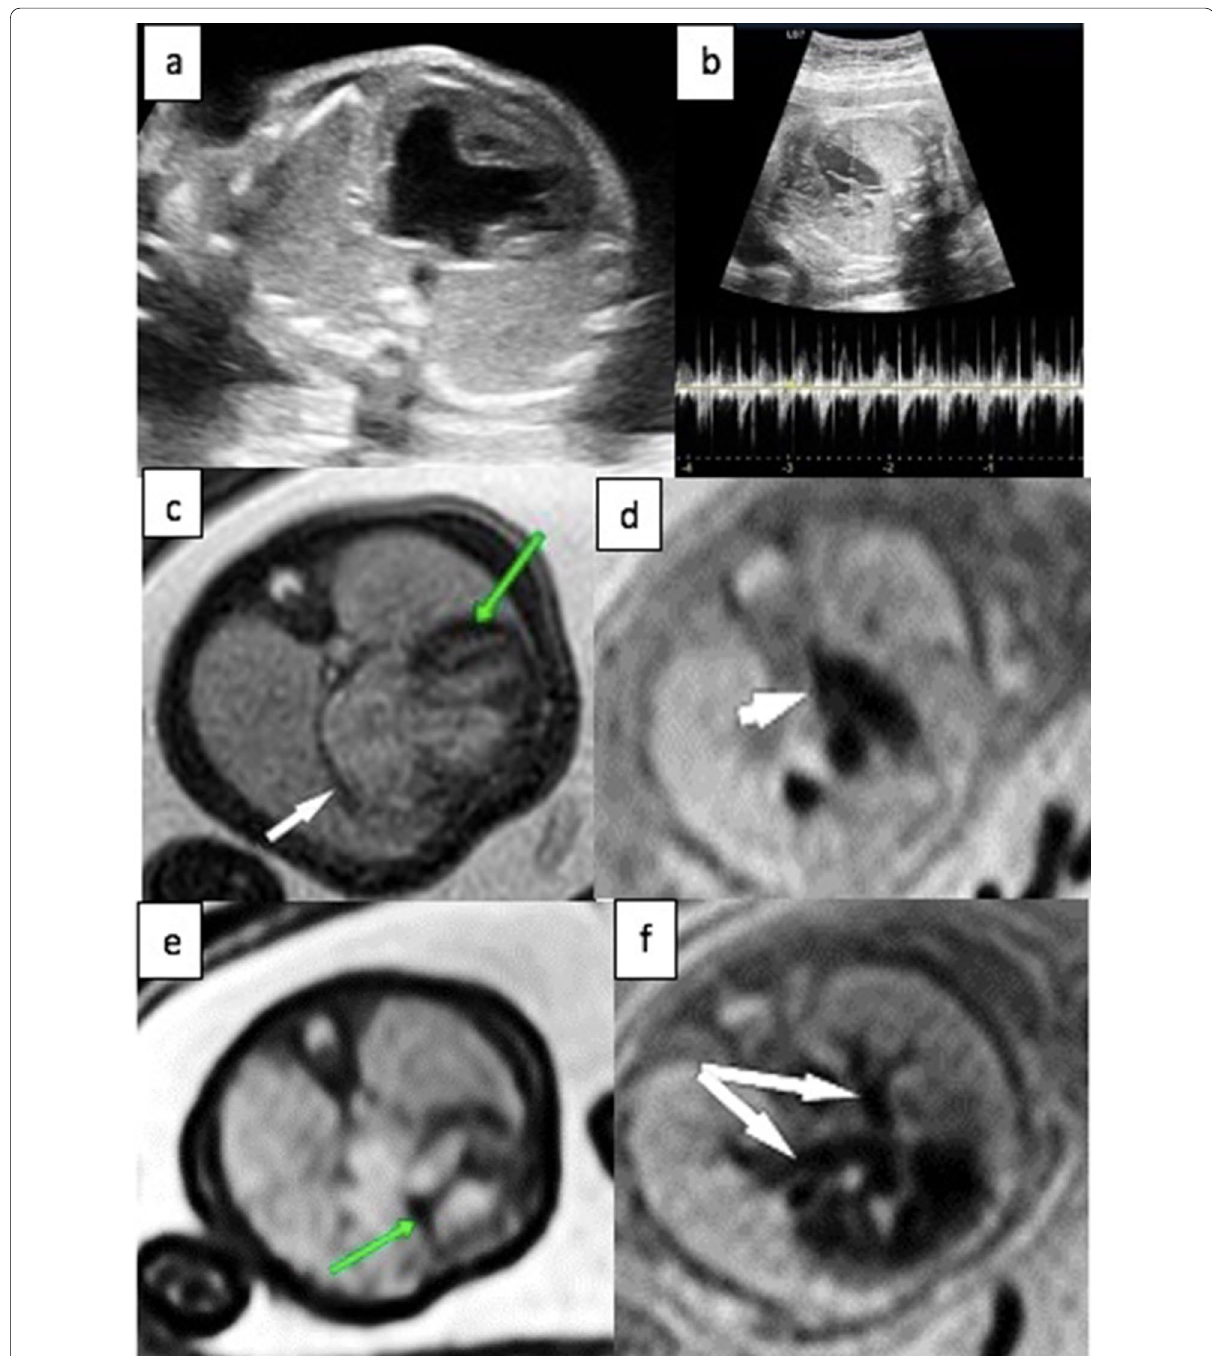
Fig. 1 38-years-old pregnant female with 29wks fetus, a , b fetal echo finding; Complete unbalanced AVSD, dilated main pulmonary artery, pulmonary regurge, (c-f) FCMRI finding: Cardiomegaly with large common atrium (white arrow in c ), hypoplastic left ventricle with atretic mitral valve and large membranous VSD (green arrow in c ), hypoplastic aortic arch (short arrow in d ), thickened tricuspid valve(green arow in e ),and normal pulmonary venous drainage to small left atrium (two arrows in f ). c , e Axial BTFE (110 flip angle) four chambers and outlet views, d , f Black blood